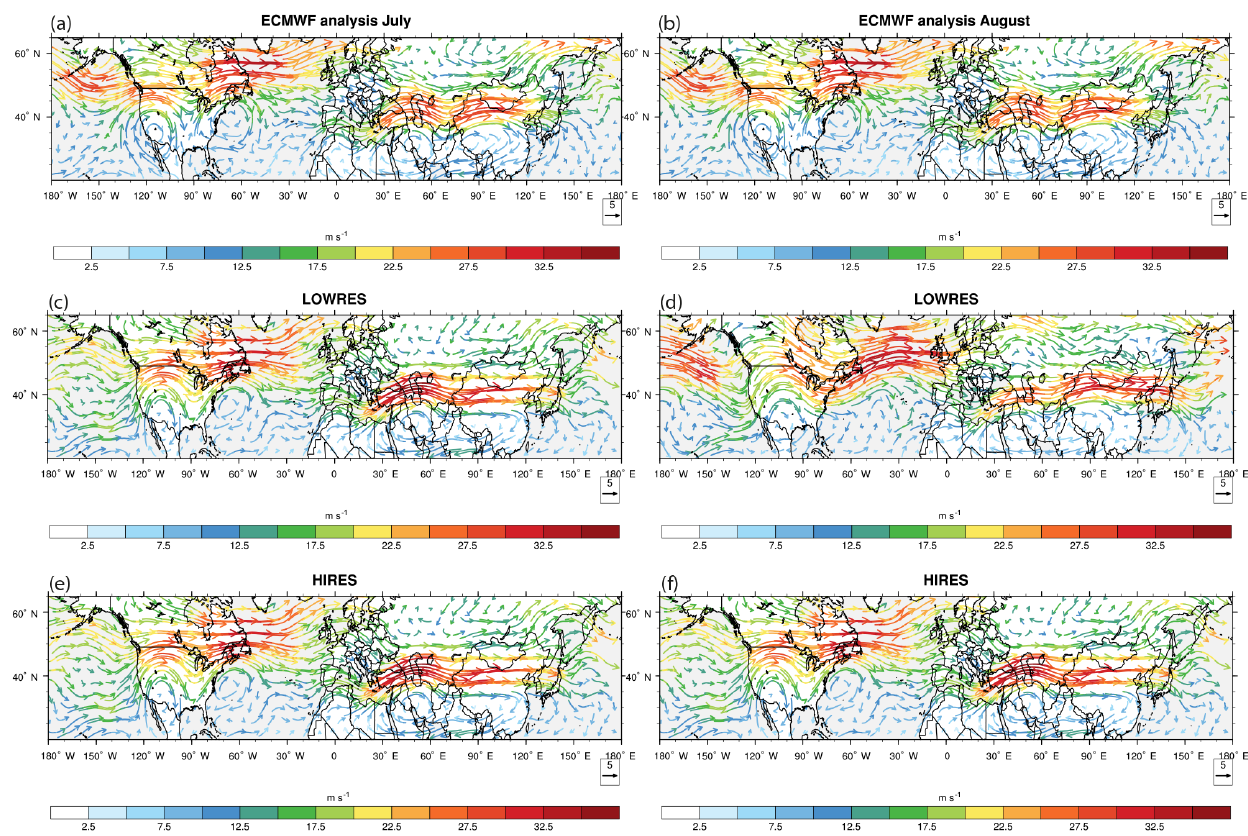
Figure 8. Mean 300hPa wind velocities for July 2013 (a, c, e) and August 2013 (b, d, f) . The top row shows the ECMWF analysis, the middle row shows the LOWRES simulation, and the bottom row displays the HIRES